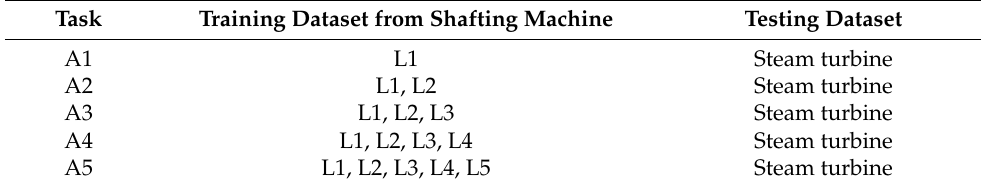
Table 3. Description of fault diagnosis